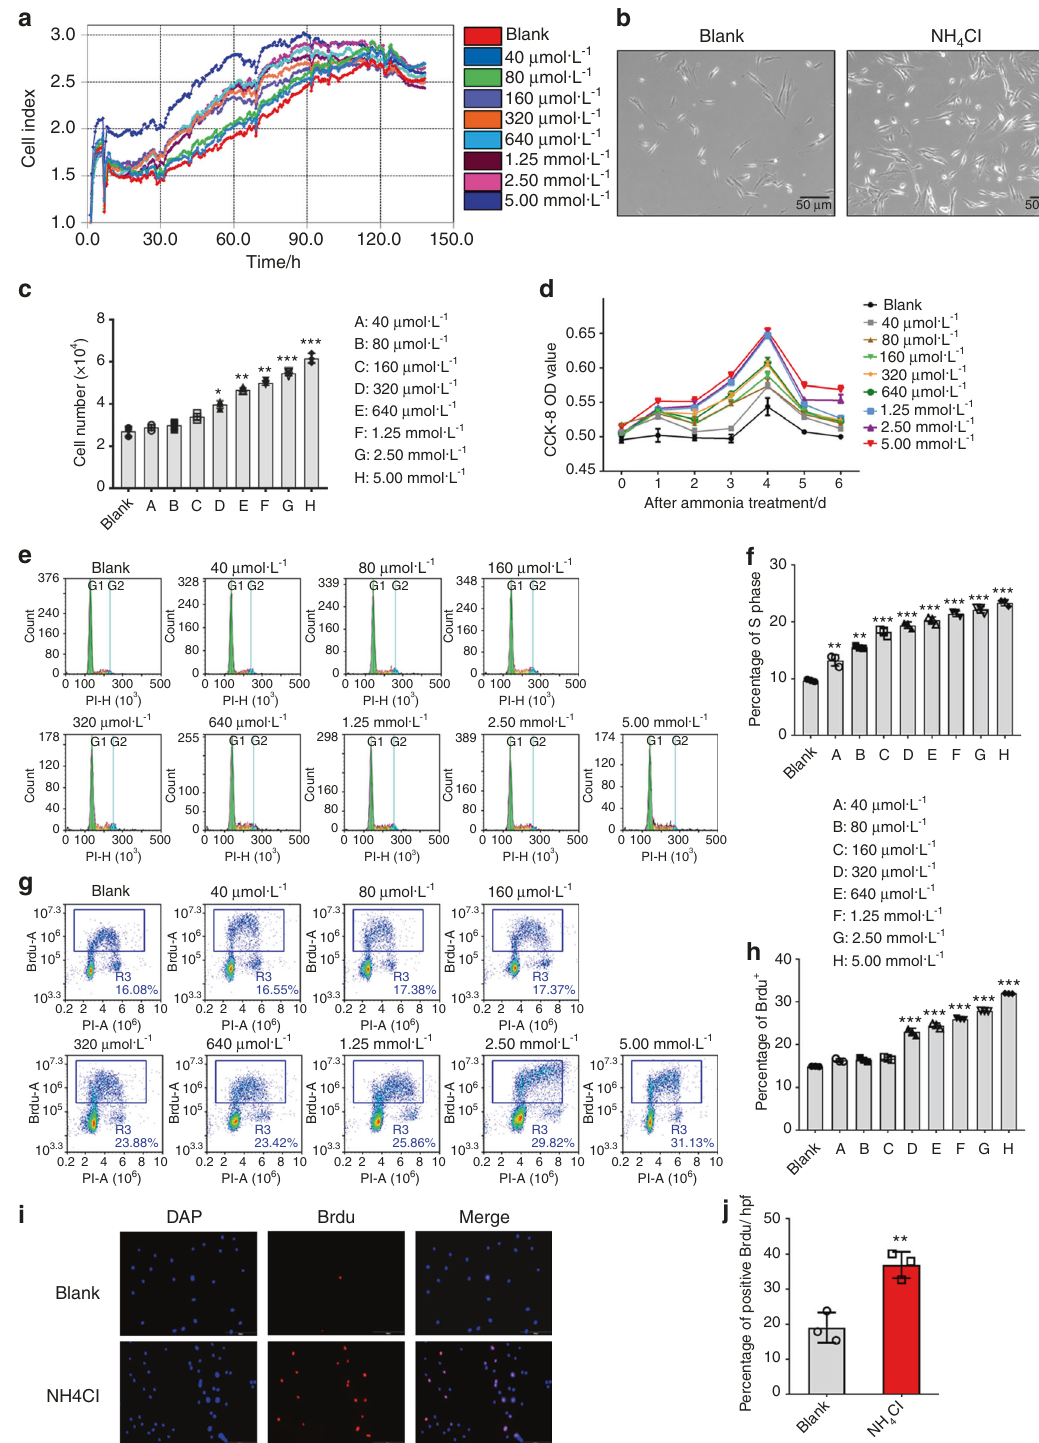
Fig. 2 Ammonia promotes mesenchymal stem cell proliferation. a RTCA (real-time cellular analysis) of different concentrations of NH 4 Cl (0, 40 µmol·L − 1 , 80 µmol·L − 1 , 160 µmol·L − 1 , 320 µmol·L − 1 , 640 µmol·L − 1 , 1.25 mmol·L − 1 , 2.50 mmol·L − 1 , 5.00 mmol·L − 1 , and 10 mmol·L − 1 ). b The growth of MSCs with or without NH 4 Cl treatment under a microscope after 48 h. c Cell counts after treatment with different concentrations of NH 4 Cl (0, 40 µmol·L − 1 , 80 µmol·L − 1 , 160 µmol·L − 1 , 320 µmol·L − 1 , 640 µmol·L − 1 , 1.25 mmol·L − 1 , 2.50 mmol·L − 1 , 5.00 mmol·L − 1 , and 10 mmol·L − 1 ) after 48 h. d CCK-8 analysis with different concentrations of NH 4 Cl treatment (0, 40 µmol·L − 1 , 80 µmol·L − 1 , 160 µmol·L − 1 , 320 µmol·L − 1 , 640 µmol·L − 1 , 1.25 mmol·L − 1 , 2.50 mmol·L − 1 , 5.00 mmol·L − 1 , and 10 mmol·L − 1 ) lasting 1 week (right). e PI fl ow cytometry analysis. f The statistical results of the percentage of S phase cells. f BrdU fl ow cytometry analysis. g The statistical results of the percentage of BrdU + cells. h Immuno fl uorescence analysis of BrdU. j The statistical results of BrdU-positive cells/HPF. Values are the mean ± SEM of an experiment performed in triplicate (a two-tailed, paired Student ’ s t test). * P < 0.05 versus the controls. # P < 0.05 versus the 5 mmol·L − 1 NH 4 Cl treatment group Bone Research (2022)